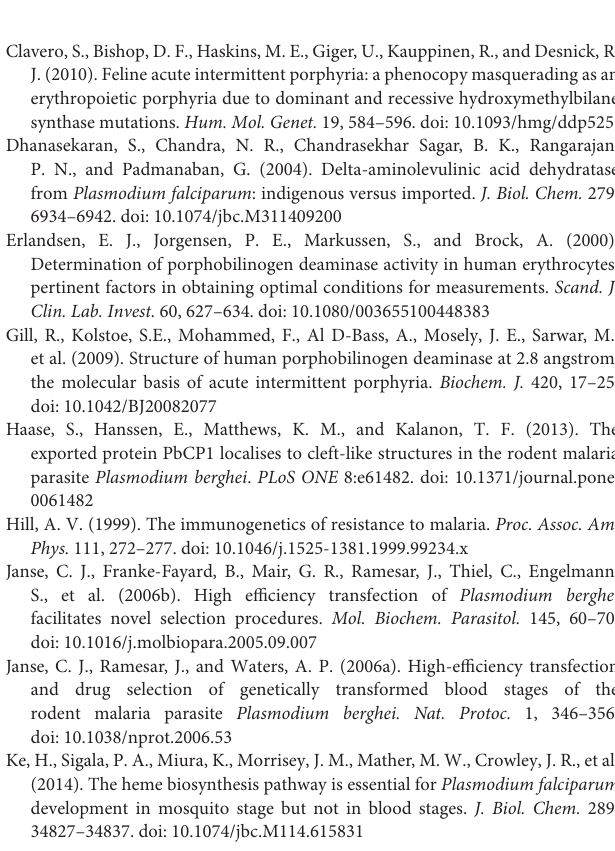
Figure S2 | Hematological analysis of the PbgdMRI58155 mouse line. (A) Comparison of erythrocyte life span, (B) osmotic strength, and (C) bone-marrow erythroid progenitor cells in PbgdMRI58155 heterozygotes (Het, n = six to nine mice) and wild-type littermates (WT, n = six to seven mice). Error bars represent